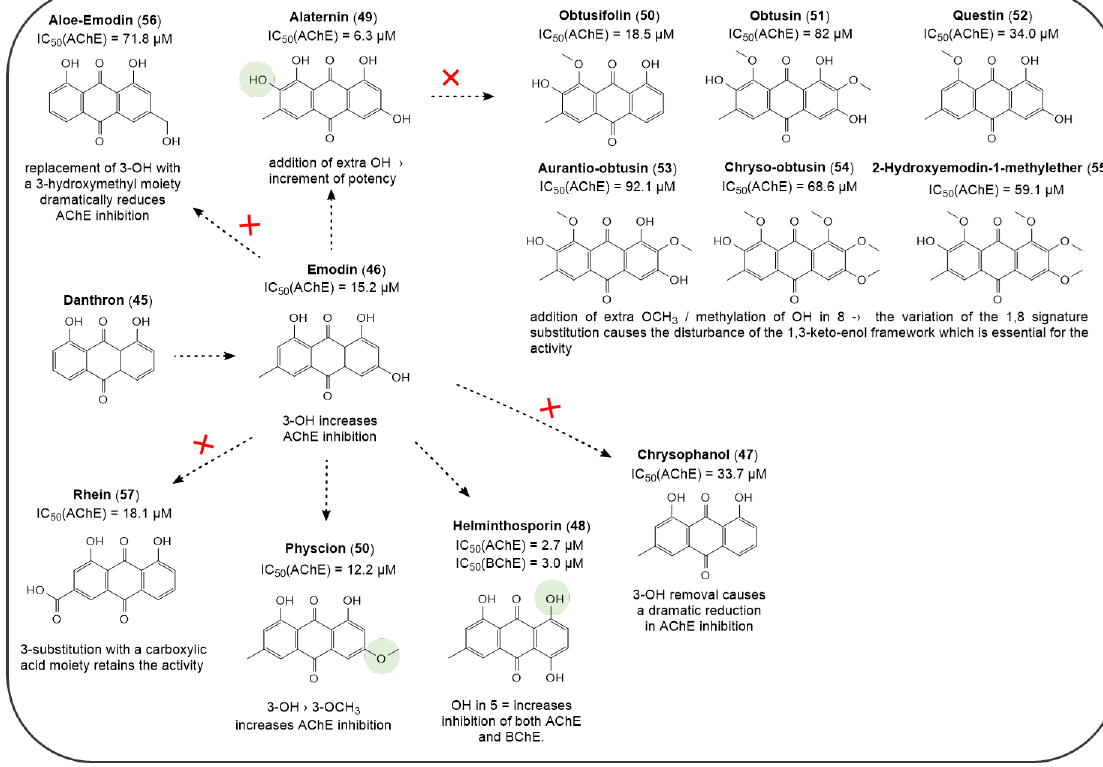
Figure 12. Representative AQs as ChEs inhibitors; x symbol indicates the negative impact on the activity exerted by some substitutions in a few emodin analogues.